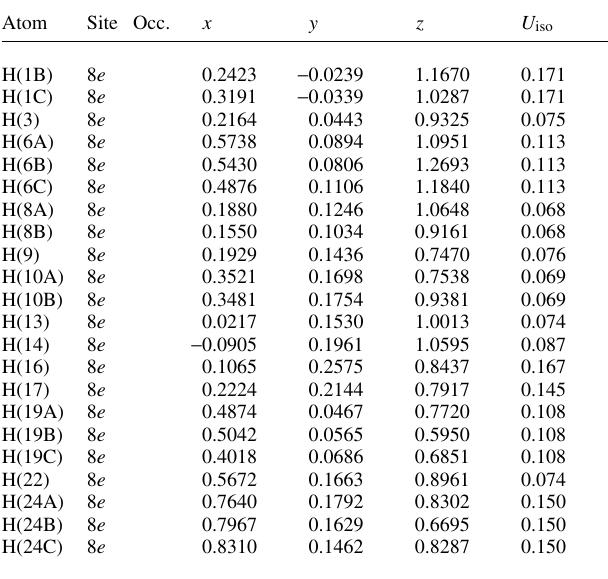
Table 1. Data collection and